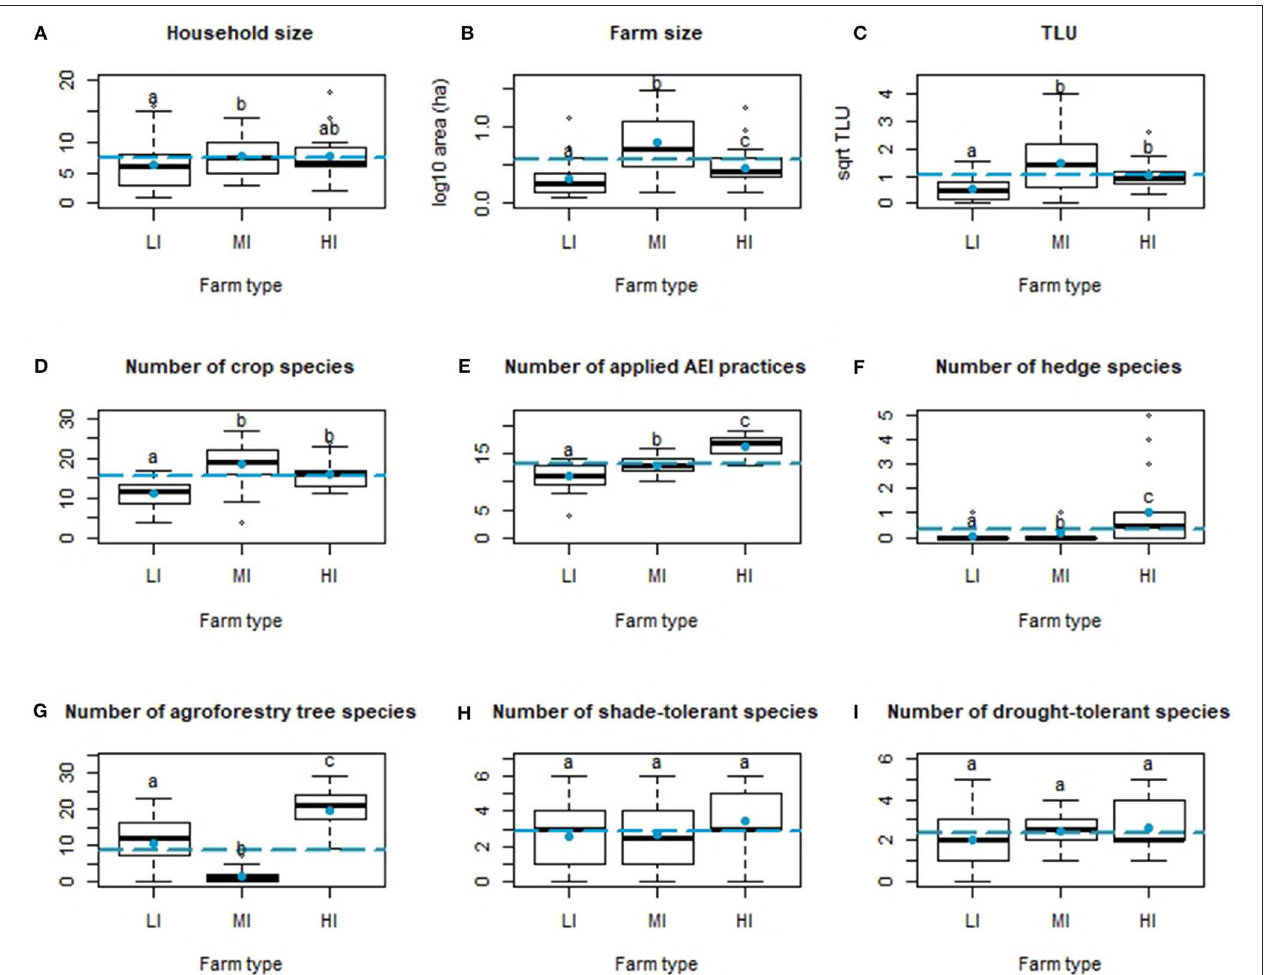
FIGURE 3 | Boxplots of the three farm types, ordered by increasing number of applied AEI practices (LI: low intensified farms, MI: moderately intensified farms and HI: highly intensified farms), for the variables household size (A) , farm size (B) , tropical livestock units (C) , number of cultivated crop species (D) , number of applied AEI practices (E) , number of hedge species (F) , number of agroforestry species (G) , number of shade- and drought-tolerant species (H,I) . Blue points represent the cluster means, thick solid horizontal lines the median values, box outlines the interquartile range containing the middle 50% of values, whiskers the 90th percentile values, gray points the outlier values and the dashed blue line the survey means of each variable. Small letters above the whiskers of the boxplots represent the output of the pairwise Wilcoxon test. Cluster means that are significantly different at the 0.05 significance level are indicated by a different letter. Only boxplots of the same quantitative variable can be